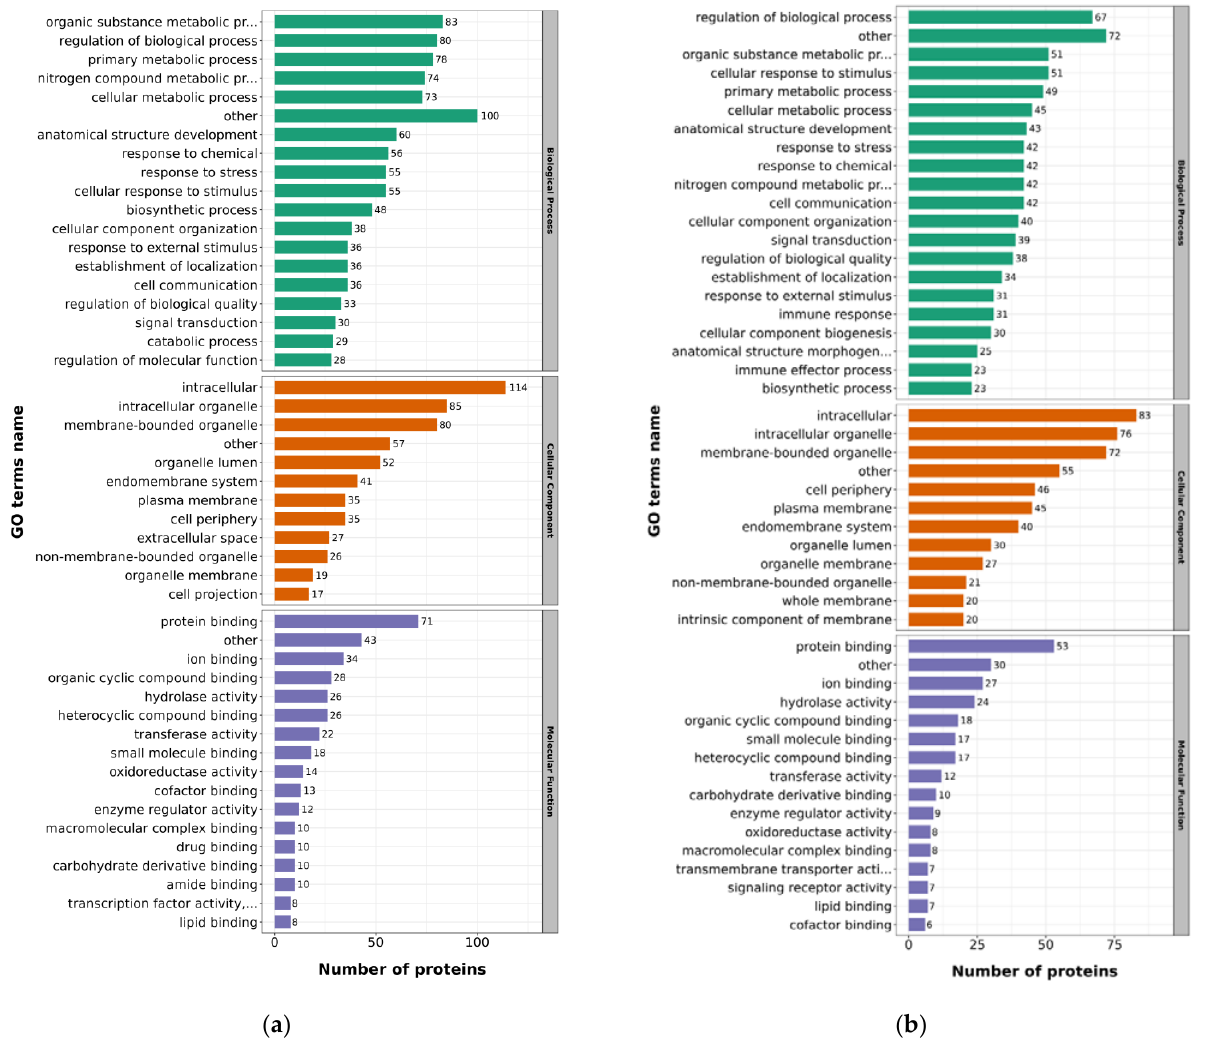
Figure 3. GO annotation of the DEPs. ( a ) GO annotation of the up-regulated proteins; ( b ) GO annotation of the down-regulated proteins.